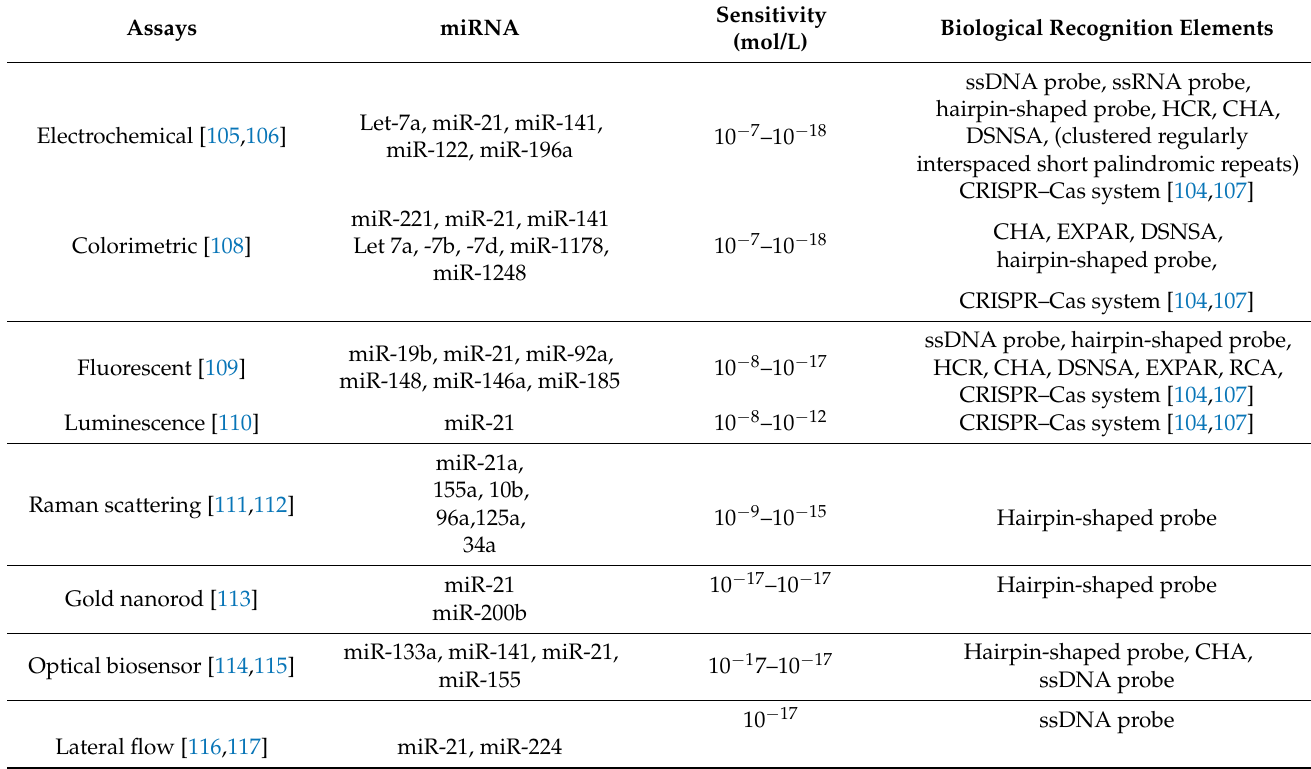
Table 5. Various miRNA detection